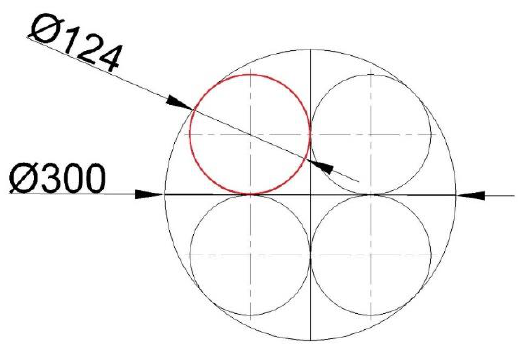
Figure 4. Diameter of one chamber modified for calculations.